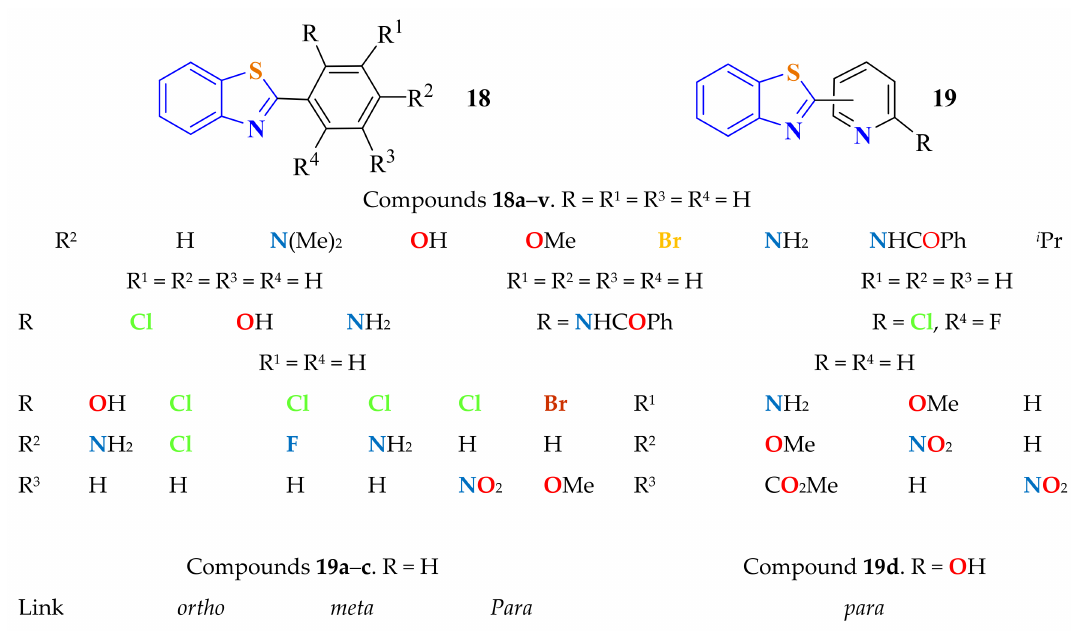
Figure 5. 2-substitutedphenylbenzothiazoles and 2-substitutedpyridinylbenzothiazoles. Kini et al. refluxed ATP with substituted benzoic acids in the presence of PPA at a high temperature to get 2-arylBTs 20 (Scheme 10) in 74% yield. Compound 20 was evaluated against the human cervical cancer cell lines as an anticancer drug [115].